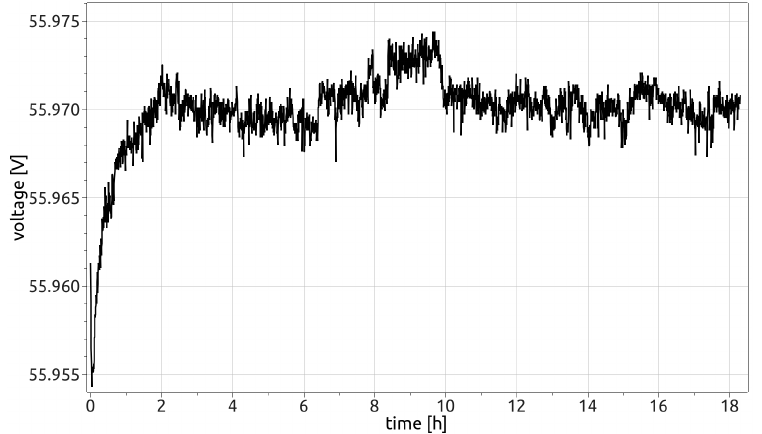
Figure 14. Voltage U during heat-up of main AFE measured using the Keithley voltmeter.